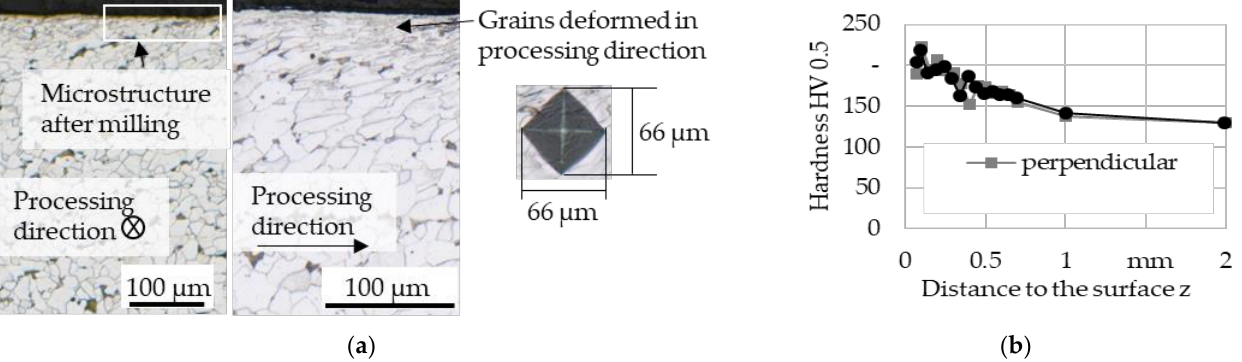
Figure 11. ( a ) Microstructure underneath a pulsed mechanically treated surface in comparison to the initial milled state, ( b ) corresponding HV0.5 measurement for specimen after processing with type 1.